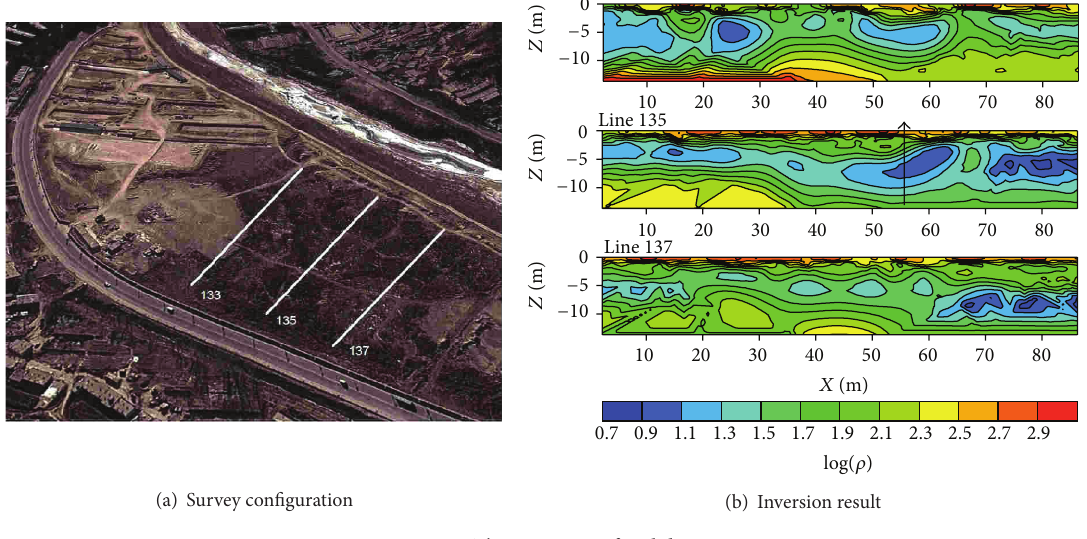
Figure 9: The inversion of real